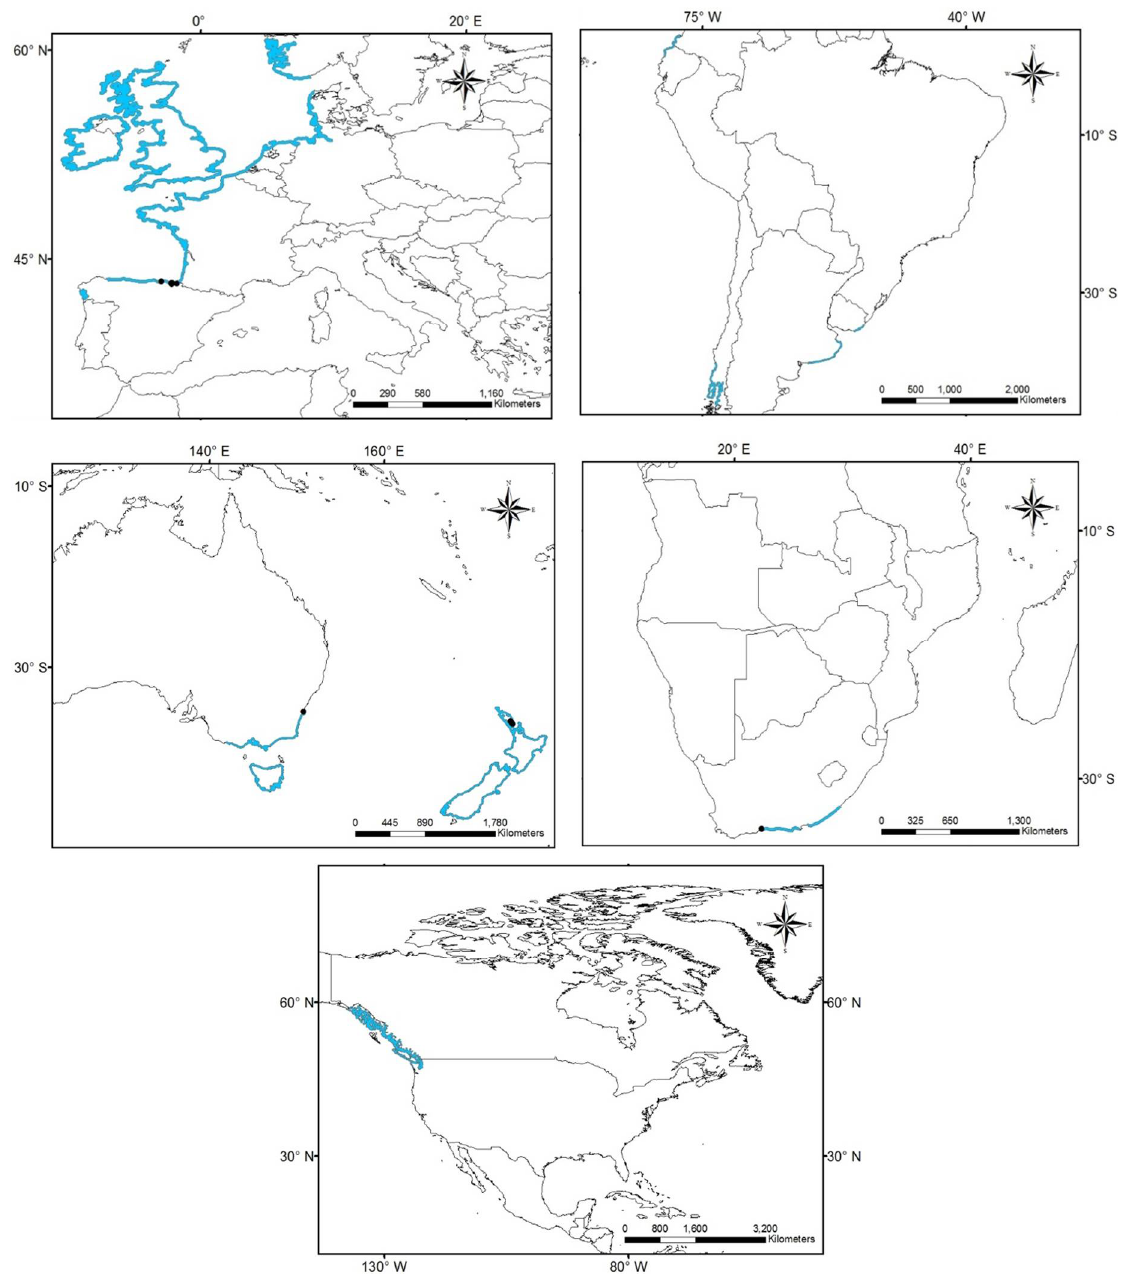
Figure A7. Training (blue) and projection (green) areas for the construction of the models corresponding to Temperate oceanic climate (Cfb). Black dots represent occurrence records.